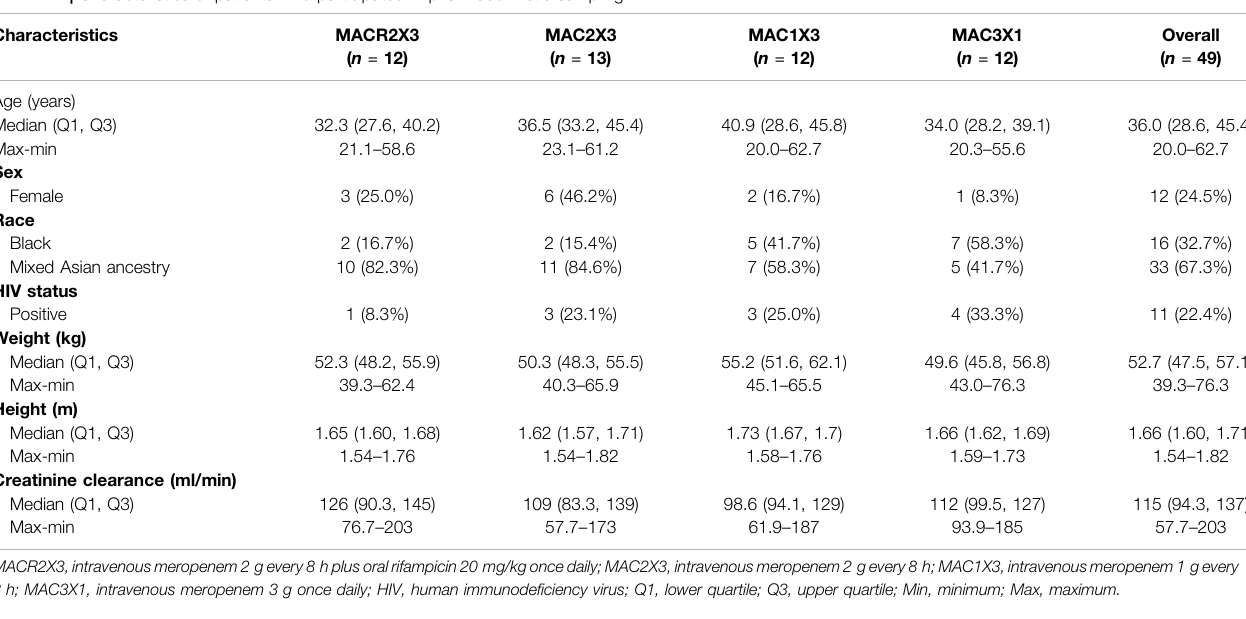
TABLE 1 | Characteristics of patients who participated in pharmacokinetic sampling.